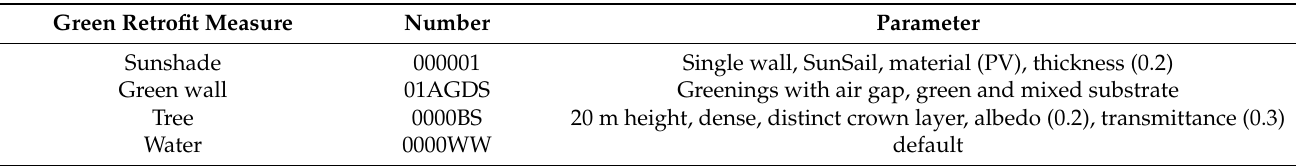
Table 8. ENVI-met parameters of green retrofit measures.